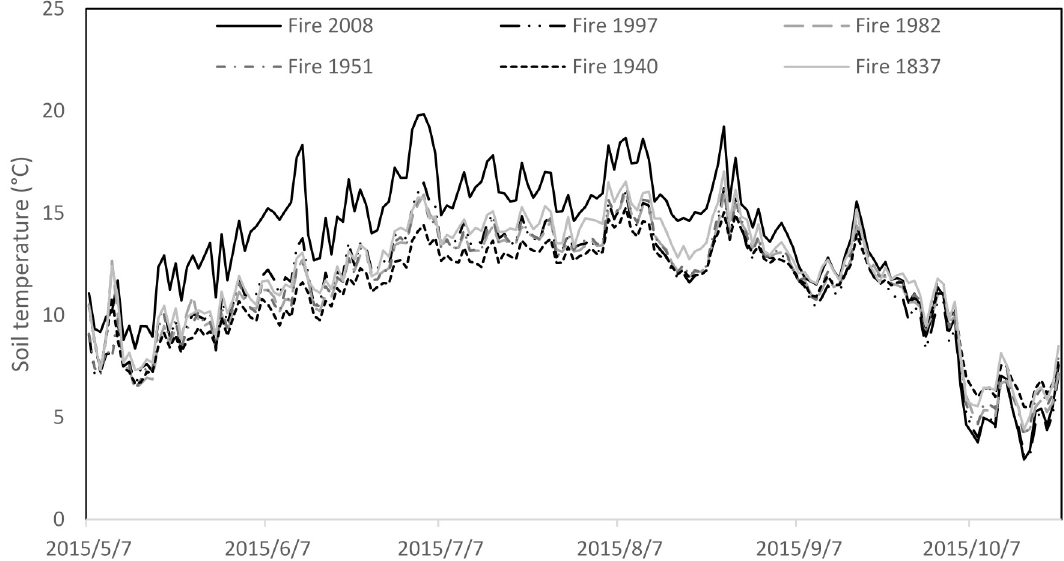
Figure 1. Daily average soil temperatures (24 h average, °C) during the measurement period in a fire chronosequence.